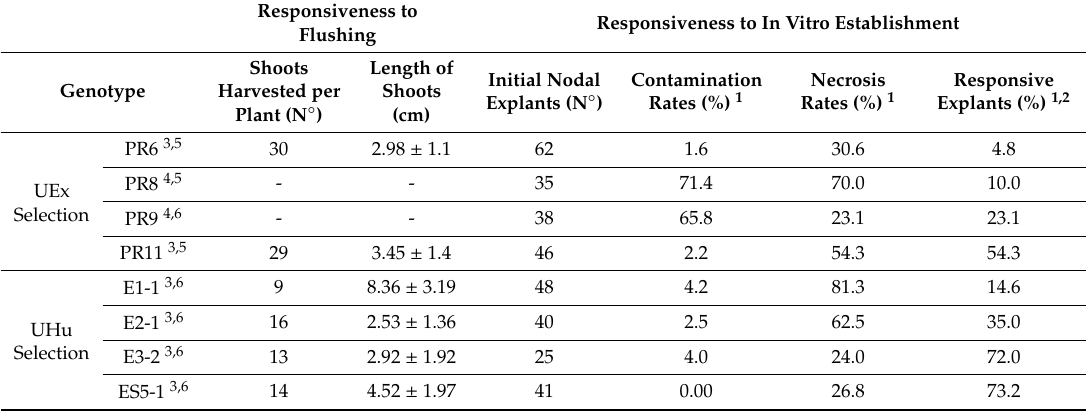
Table 1. Flushing capacity of di ff erent potted tolerant Quercus ilex plants and in vitro establishment of nodal explants excised from flushed